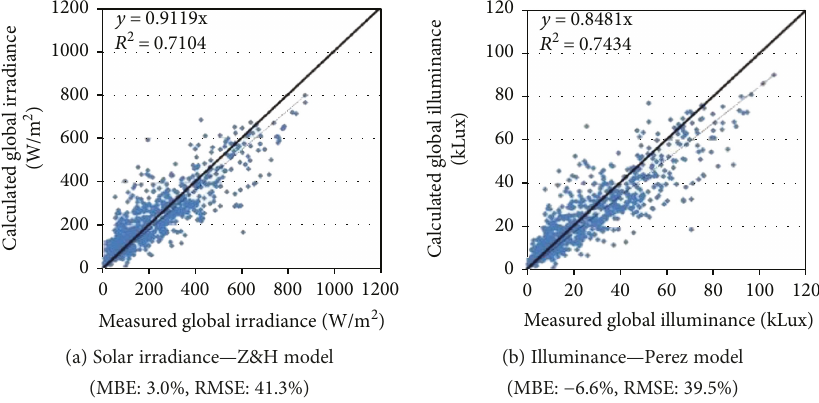
Figure 3: Scatter plotting of global solar radiation and luminous e ffi cacy models performance for Manchester, UK (1993).